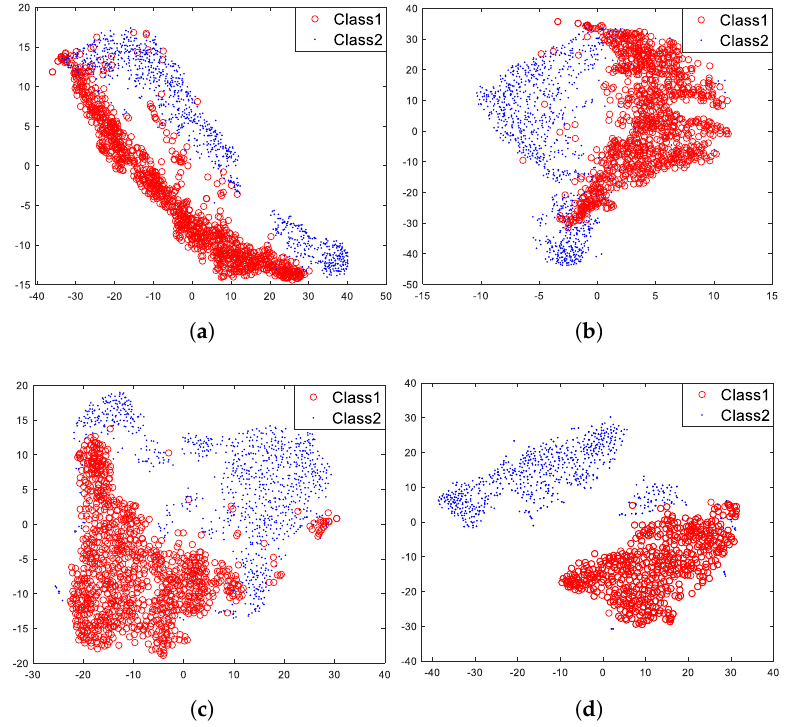
Figure 15. Feature visualization after fine-tuning with the supervised feature-separation